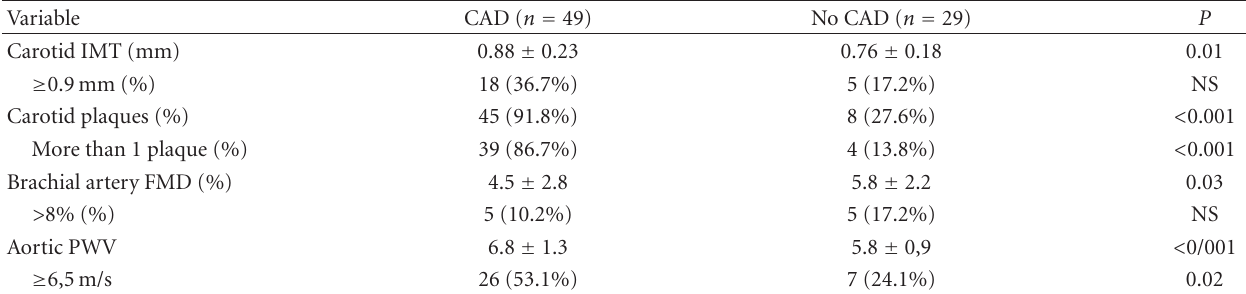
Table 2: Structural and functional status of the arteries in young and middle-aged men with recently developed CAD. Variable CAD ( n = 49)